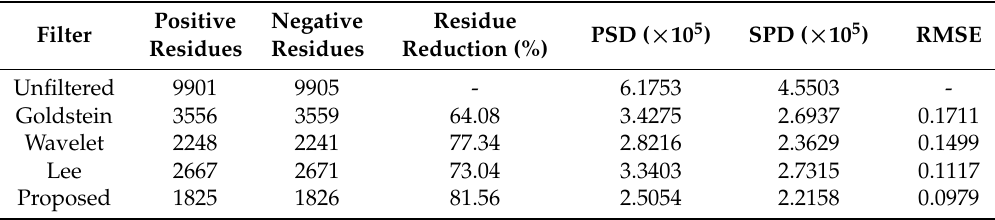
Table 3. Quantitative evaluation with real data over Hong Kong.